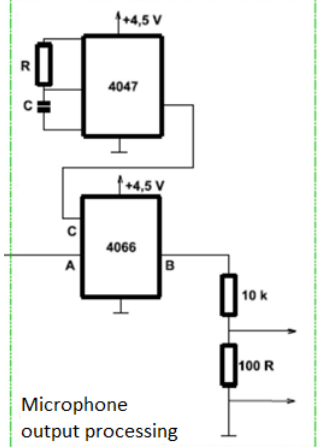
Figure 6. Diagram of microphone output